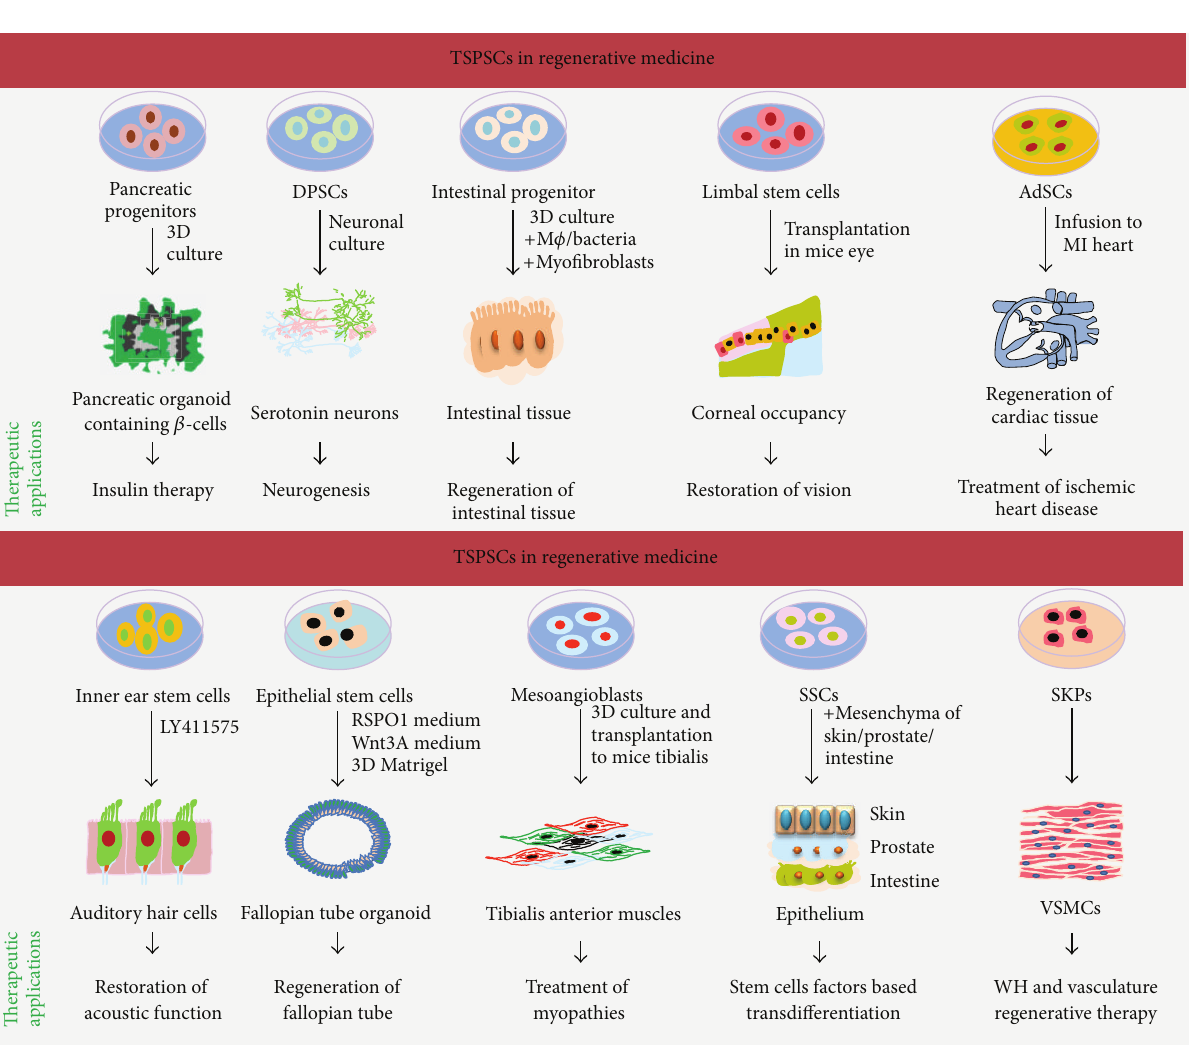
Figure 3: TSPSCs in regenerative medicine: tissue specific stem and progenitor cells have potential to differentiate into other cells of the tissue. Characteristically inner ear stem cells can be transformed into auditory hair cells, skin progenitors into vascular smooth muscle cells, mesoangioblasts into tibialis anterior muscles, and dental pulp stem cells into serotonin cells. The 3D-culture of TSPSCs in complex biomaterial gives rise to tissue organoids, such as pancreatic organoid from pancreatic progenitor, intestinal tissue organoids from intestinal progenitor cells, and fallopian tube organoids from fallopian tube epithelial cells. Transplantation of TSPSCs regenerates targets tissue such as regeneration of tibialis muscles from mesoangioblasts, cardiac tissue from AdSCs, and corneal tissue from limbal stem cells. Cell growth and transformation factors secreted by TSPSCs can change cells fate to become other types of cell, such that SSCs coculture with skin, prostate, and intestine mesenchyme transforms these cells from MSCs into epithelial cells